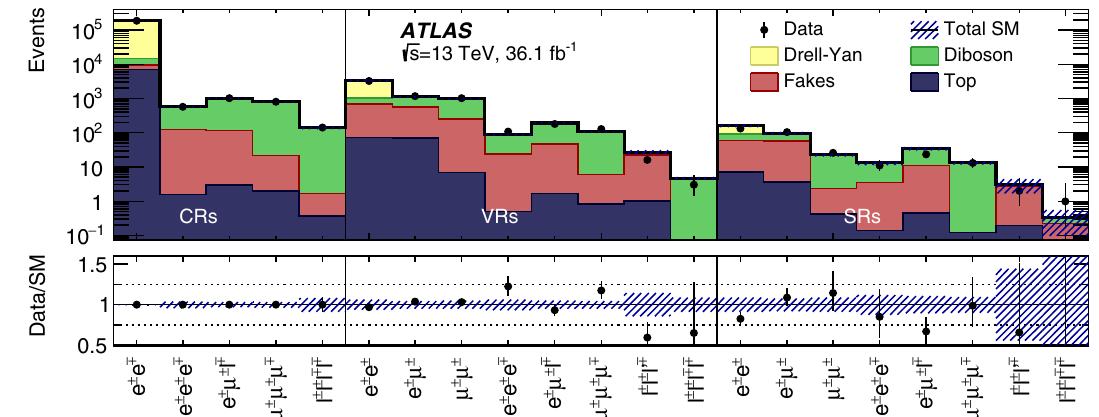
Fig. 7 Number of observed and expected events in the control, vali- dation, and signal regions for all channels considered. The background expectation is the result of the fit described in the text. The hatched bands include all systematic uncertainties post-fit with the correlations